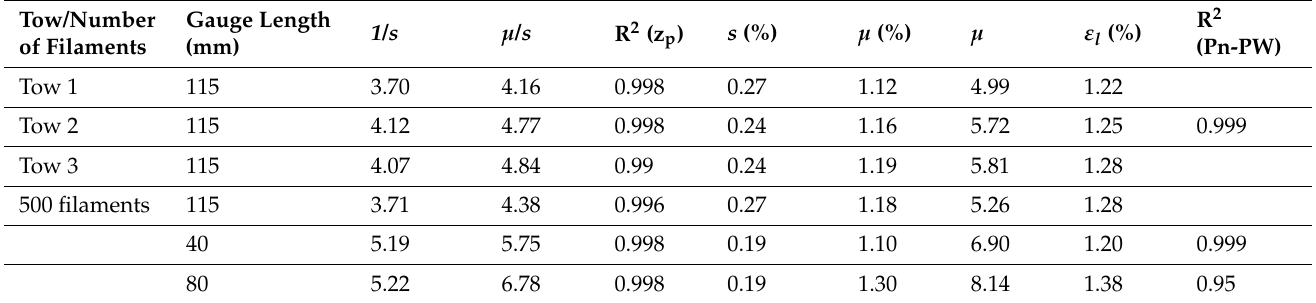
Table 3. Values of extreme strain extracted from the empirical z p ( ε p ) diagrams and related critical flaw sizes.